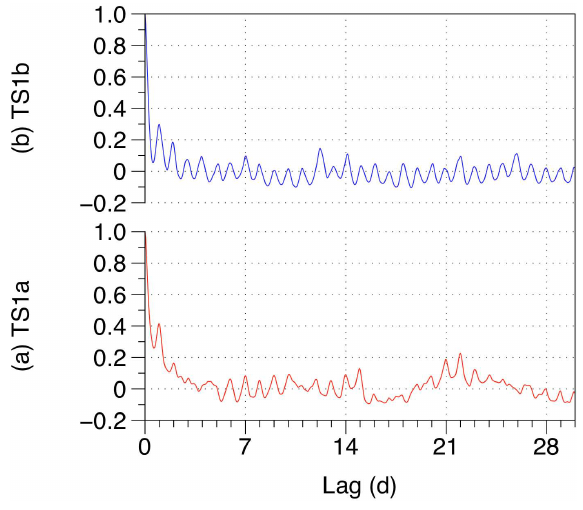
Fig. 2. Autocorrelation of the Radon Time-Series; (a) TS1a (red), (b) TS1b